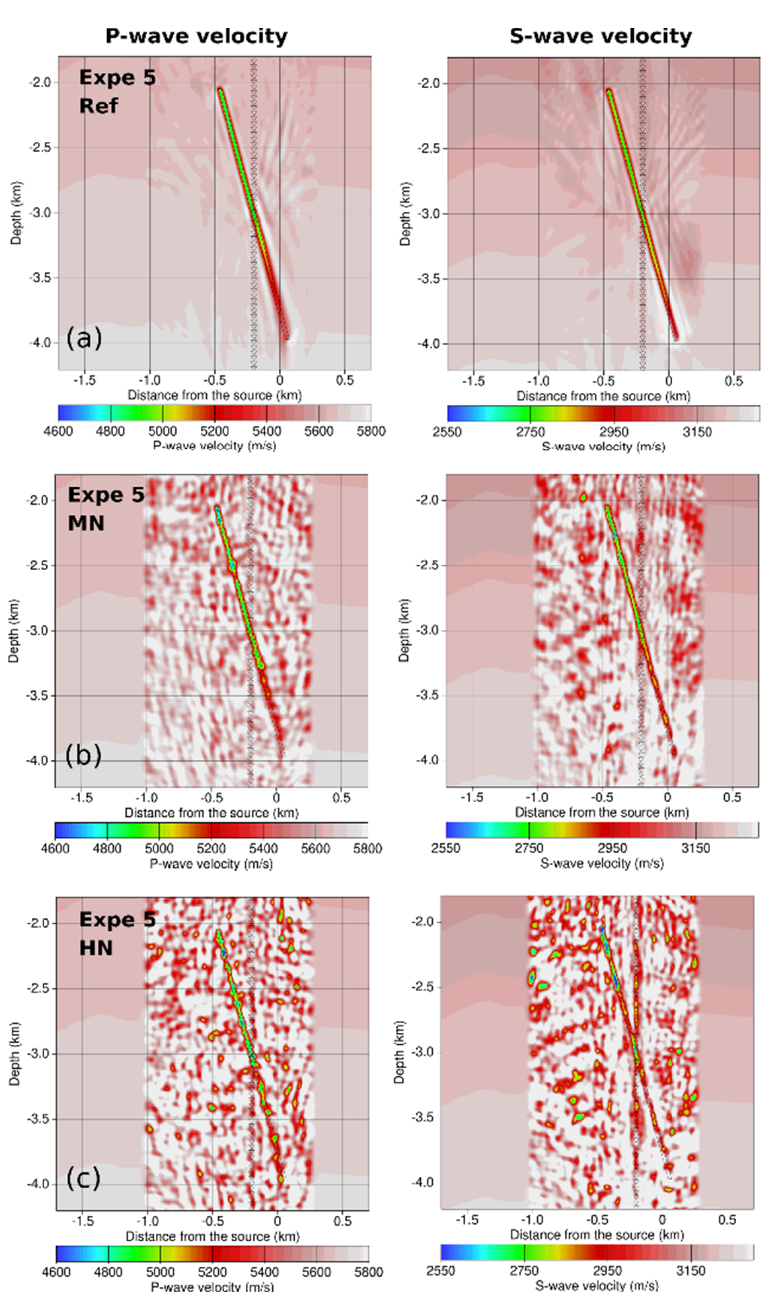
Figure 18. P- and S-wave velocity models recovered for; ( a ) the reference experiment (Ref), i.e., data free noise, ( b ) moderately noisy data (MN), and ( c ) highly noisy data (HN). We show only the target area around the fault for P-wave velocity (left) and S-wave velocity (right). The inverted triangles show the receivers and the black polygon show the shape of the fault.